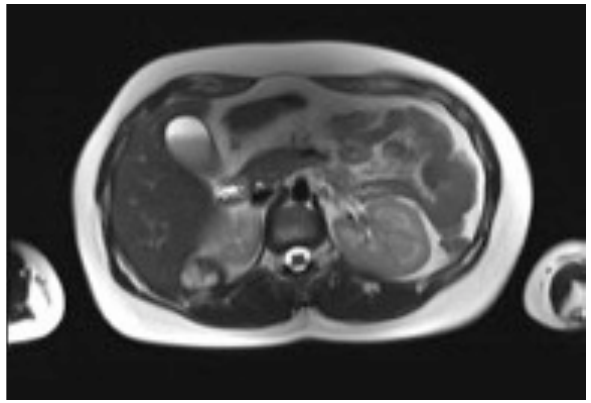
Figure 1: Rm scan T1weighted axial image showing the adrenal